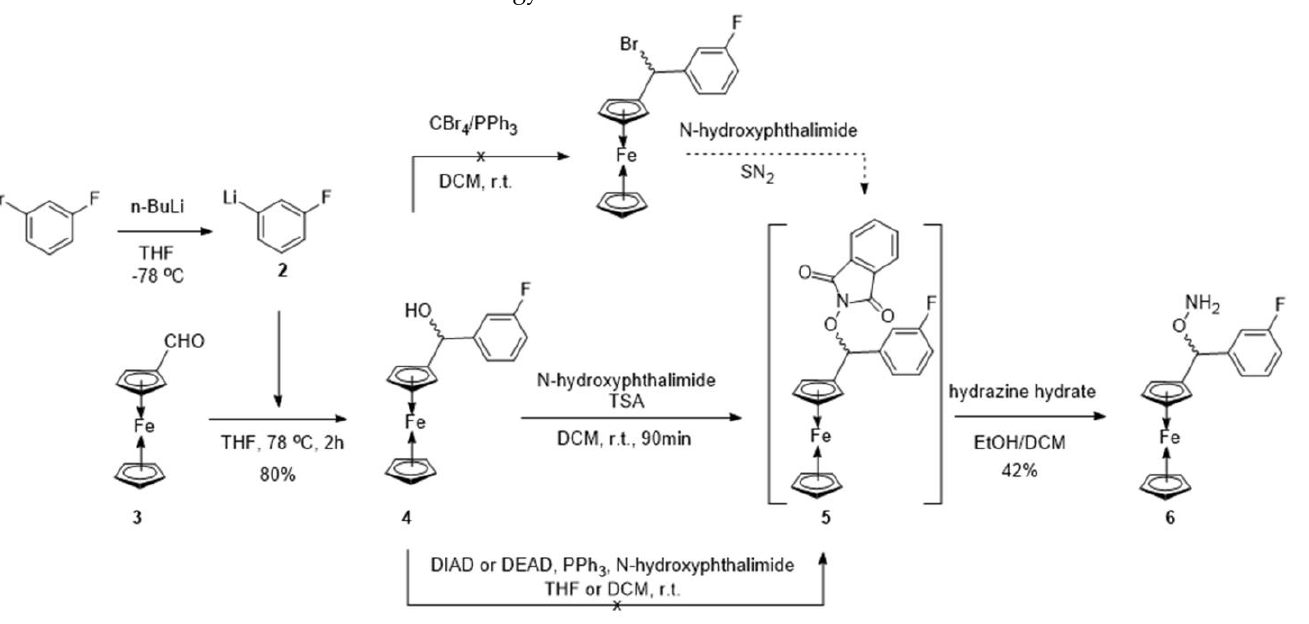
Figure 1. Bioisosteric replacement of a phenyl group with ferrocenyl moiety on a known KP pan-